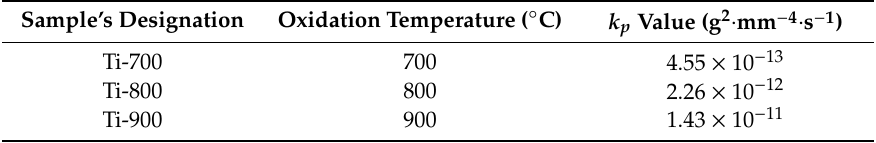
Figure 1. Curves of ( a ) mass gain vs. exposure time and ( b ) square of the mass gain per unit area vs. exposure time for the oxidized Ti samples at various temperatures. Table 1. Parabolic rate constants ( k p ) of the oxidized titanium (Ti) samples at various temperatures.